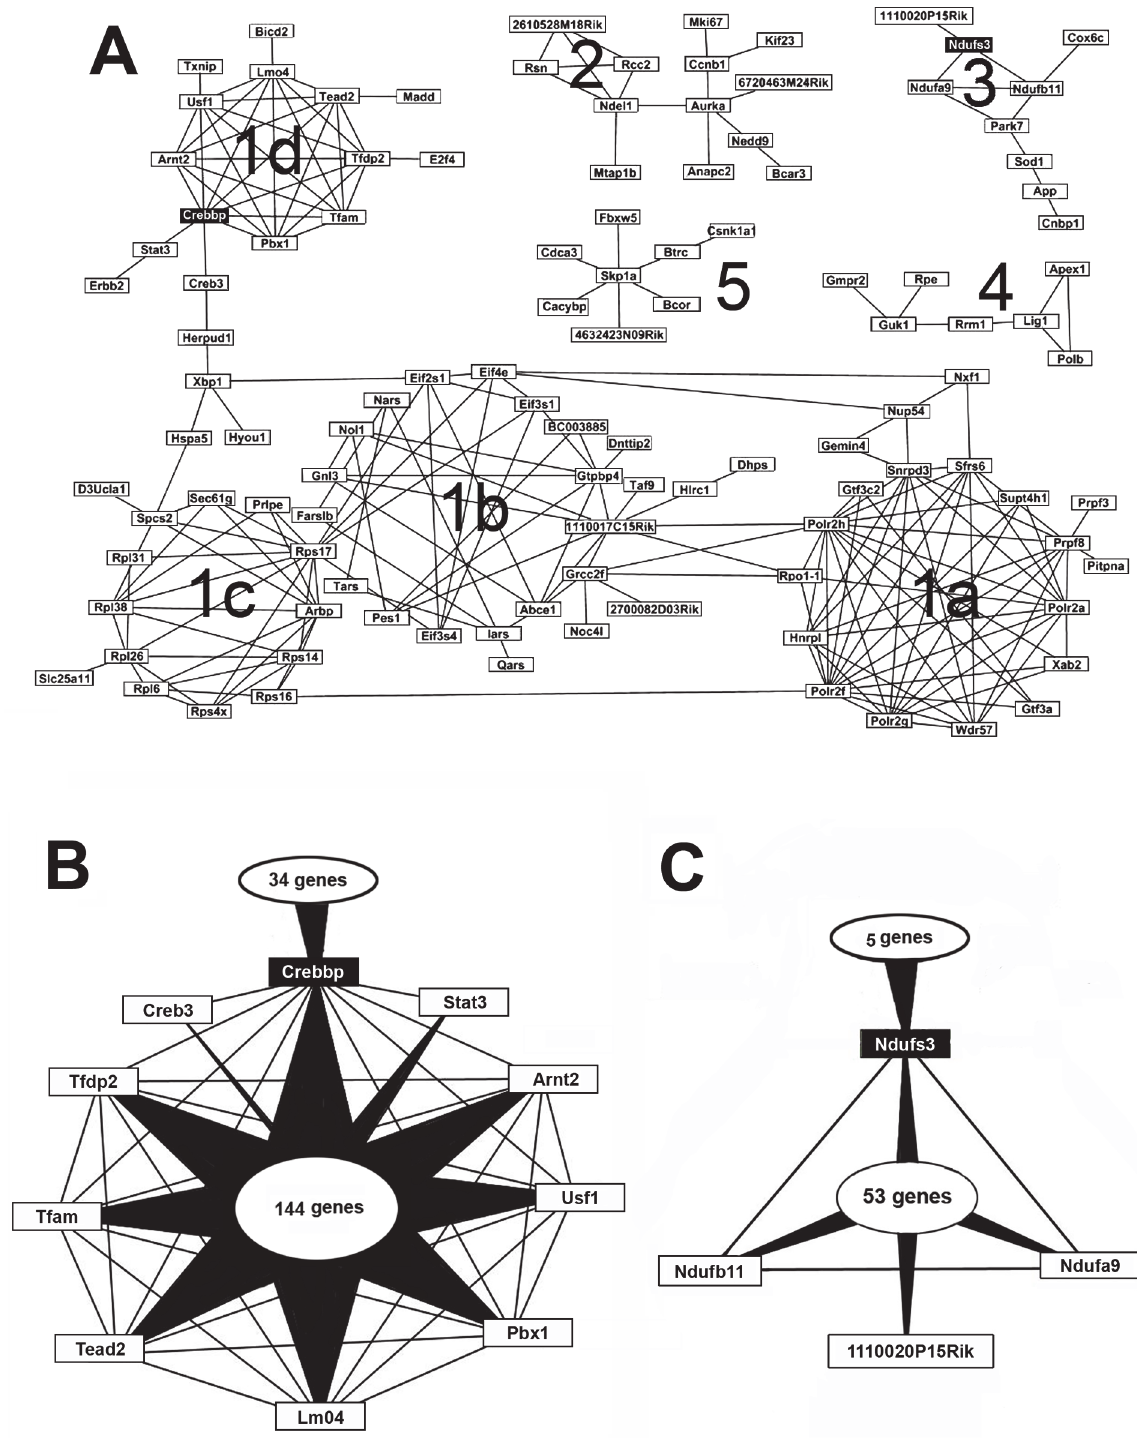
Fig 6. Interactome networks for the KUROV genes. A: Networks (gene names boxed) with direct interactions between KUROV genes (level 3). The largest network (1) with sub-networks (1a to 1d) and less populated networks are shown (2 to 5). Black boxes: gene interactions examined in B and C. B: Schematic representation of level 2 interaction network of Creppb (CREB-binding protein) depicting the 144 non-KUROV genes joining the 9 KUROV genes from sub-network 1d. C: Level 2 interaction network of Ndufs3 (NADH-Ubiquinone oxidoreductase Fe-S protein 3) with the 53 non-KUROV genes joining the 3 KUROV genes (Ndufb11, Ndufa9 and 1110020P15Rik) from network 3.